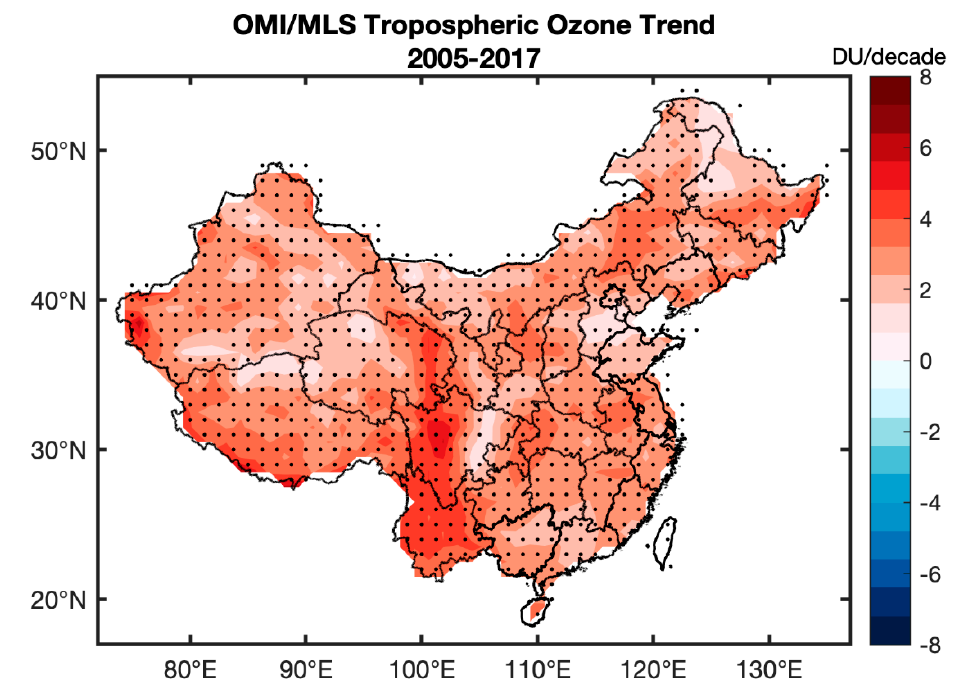
Figure 15. OMI / MLS tropospheric ozone trends over China for the 2005–2017 period. The trends were calculated as the Sen’s slope and tested using the Mann–Kendall test. Trends with a significance level > 95% are marked with black dots.